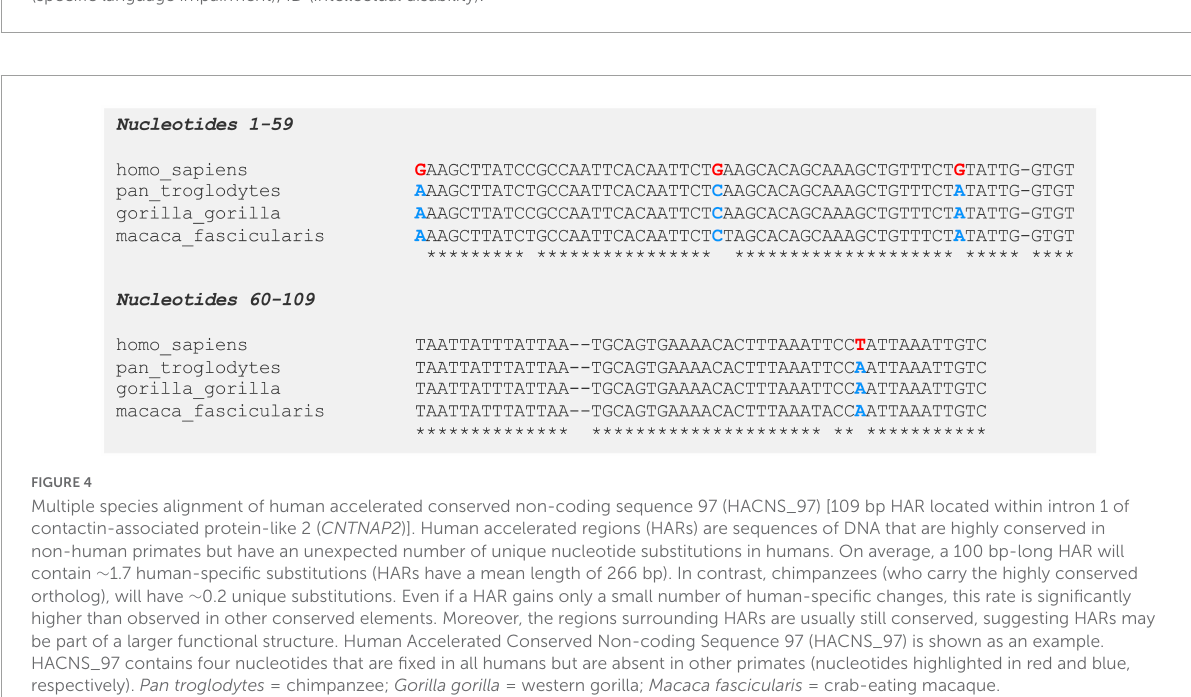
FIGURE3 Heterozygous contactin-associated protein-like 2 ( CNTNAP2 ) mutations. Mutations affecting the CNTNAP2 locus are shown with their associated disorders. Mutations in patients with multiple affected genes are marked by a star ( (cid:70) ). Autism spectrum disorder (ASD) is the most common diagnosis, though patients typically fall into multiple categories. The majority of deletions are found before exon 8. Mutations that map to a subdomain of the contactin-associated protein-like 2 (CASPR2) protein are shown separately. Diagram not perfectly to scale. Works cited are listed in Supplementary Material 2 . CDFE/PTHS (cortical dysplasia focal epilepsy); ADHD (attention deficit hyperactivity disorder); SLI (specific language impairment); ID (intellectual disability).